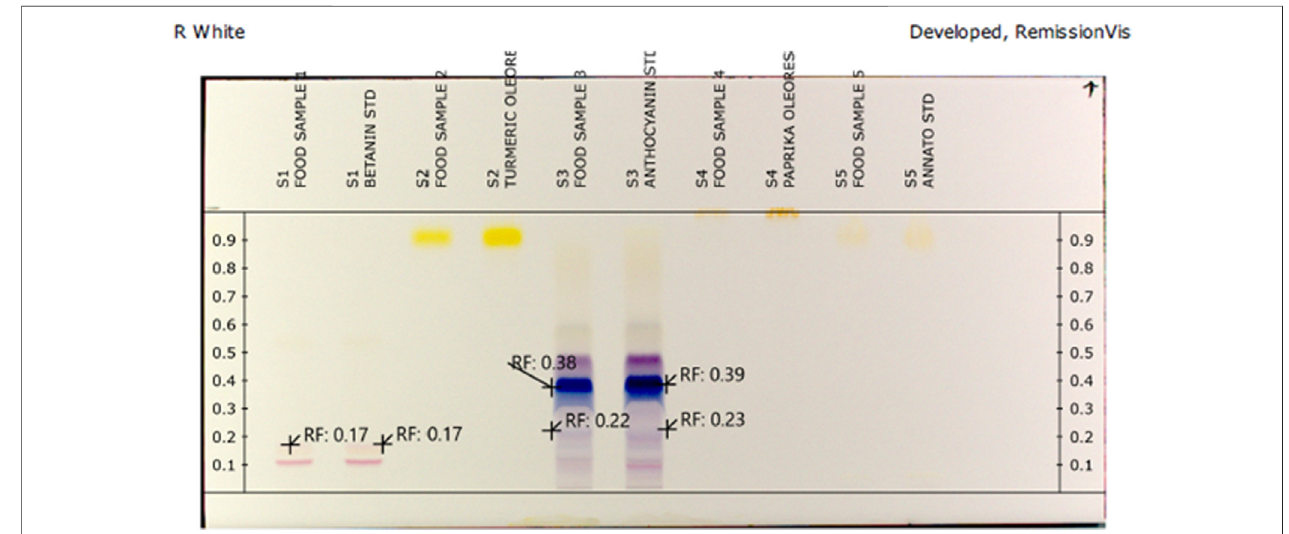
FIGURE 1 | HPTLC fi ngerprint of selected phytopigments exhibiting antioxidant property post-derivatization by the DPPH reagent.